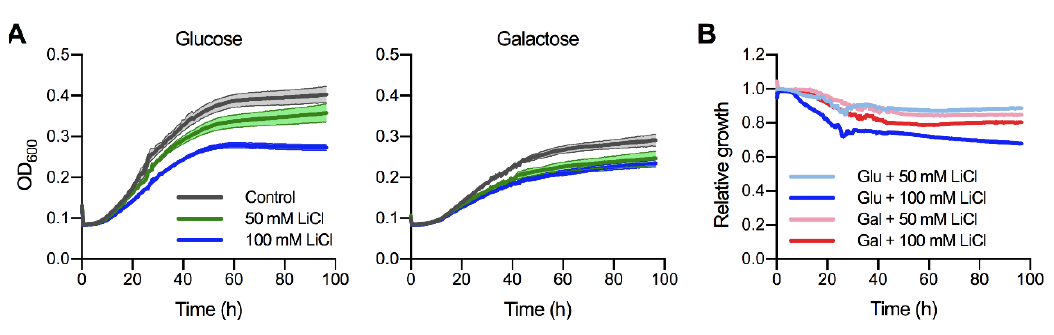
FIGURE 2: Phosphoglucomutase does not appear to be a major target of lithium in C. neoformans . (A) Growth curve analysis for C. neofor- mans H99S in YNB medium containing either 2% glucose or 2% galactose as sole carbon source at 30°C in the absence (control) or presence of lithium chloride (LiCl). Solid lines represent the means of results from two independent experiments, each performed in quadruplicate, and shaded areas represent the standard errors of the means. (B) Relative growth data from panel A. Results were plotted relative to the untreated controls. Note that cells grown in galactose were less sensitive to elevated LiCl concentrations compared to cells grown in glucose. Glu, glucose; Gal,